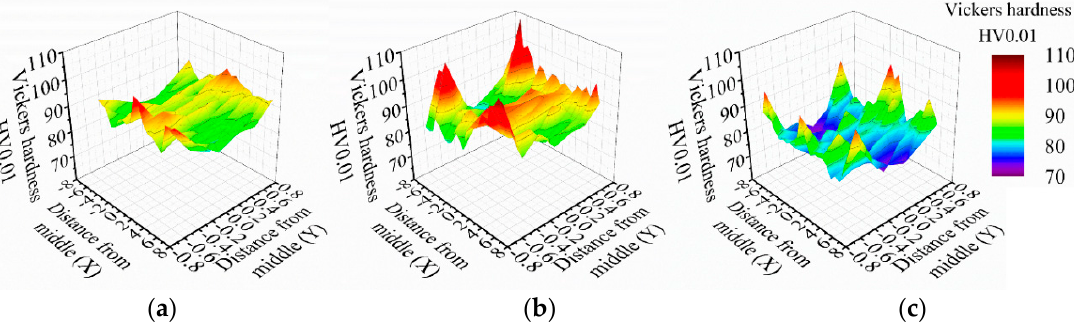
Figure 16. Microhardness mapping profile at the cross-section of the ( a ) conventional, ( b ) stationary shoulder and ( c ) dual-rotational friction stir welded (FSW) specimens.